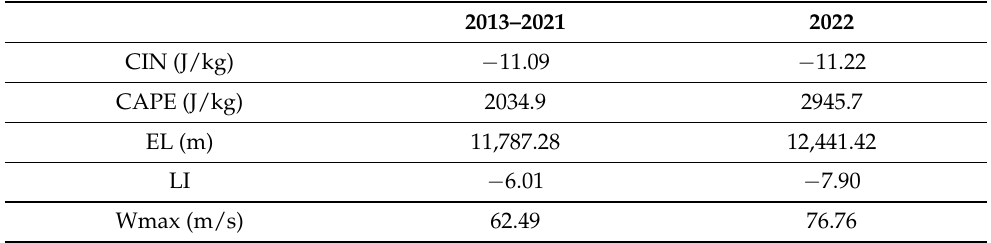
Table 1. Thermodynamic variables (from top to bottom: CIN, CAPE, EL, LI, and Wmax) compared for the campaigns of the period of 2013–2021 (left column) and 2022 (right